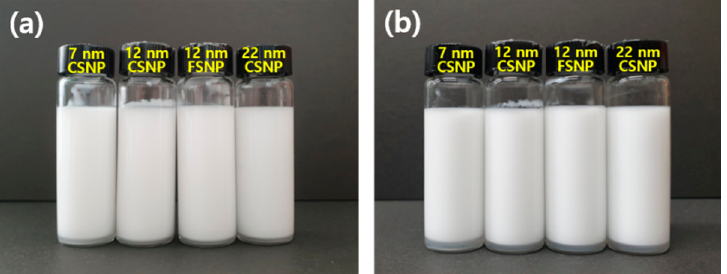
Figure 4. Phase stability tests of emulsions stabilized by differently sized NPs ( a ) immediately upon emulsion formation and ( b ) after ten days.